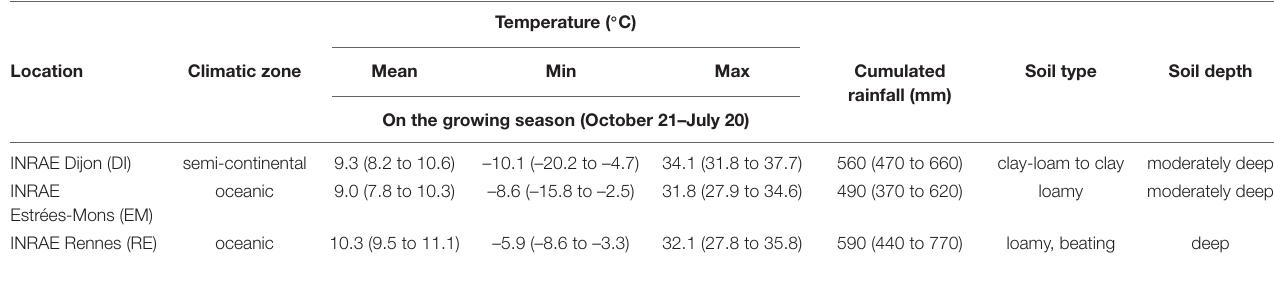
TABLE 2 | Agronomic and environmental characteristics (means in the 2006–2016 period) of the 3 French National Research Institute for Agriculture, Food and Environment (INRAE) experimental sites (Dijon, Estrées-Mons, and